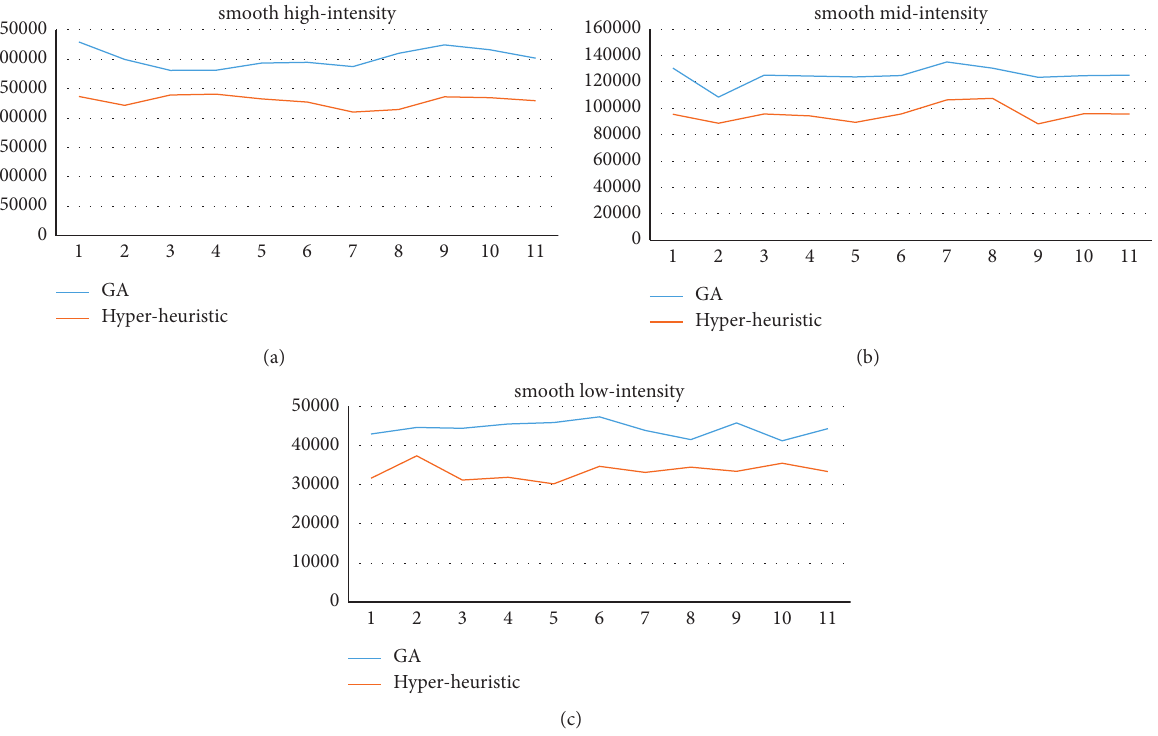
Figure 7: Result curve of GA and hyperheuristic algorithm of smooth passenger flow. (a) High-intensity passenger flow. (b) Medium- intensity passenger flow. (c) Low-intensity passenger